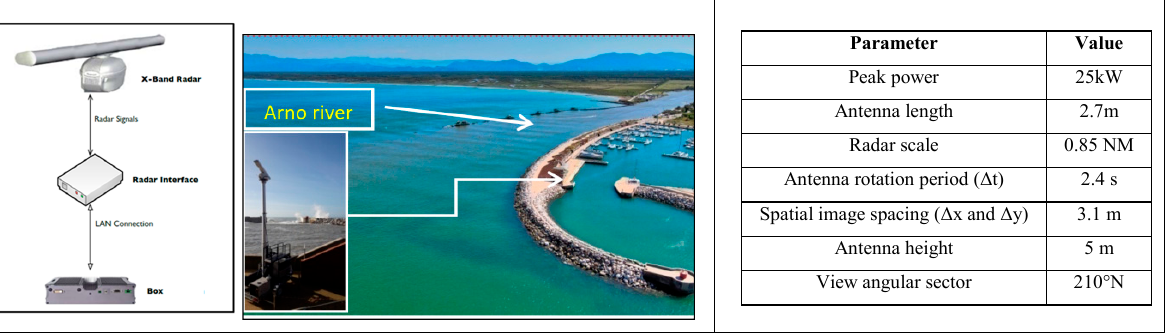
Figure 2. Wave Radar system: hardware architecture on the left. In the middle: photo of the installation site at the port of Marina di Pisa. On the right are the listed Radar system parameters. The Wave Radar system, with each radar antenna revolution, scans the sea surface with a high spatial and temporal resolution; this is achieved by the interaction (backscattering) of the electromagnetic waves (microwaves) emitted by the radar with the capillary waves (ripples) generated by the wind on the sea surface. The backscatter intensity received from the sea surface is transferred via an isolated buffer to the AD converter in a PC. The intensity of the reflected radar signal decreases with the fourth power of the distance. Currently, the analysis is restricted to an area of a few kilometres from the radar; in fact, at greater distances, due to the attenuation of the signal received, the backscattered energy input from the sea becomes more like noise than a signal. In the Wave Radar system, the data are stored, and wave analysis is conducted. One Wave Radar measurement is based on the analysis of several radar images (default is 32 imag- es). The resulting wave information, including individual wave spectra and a time series of the main statistical wave parameters, are stored and displayed on the Wave Radar graphical user interface (GUI) [62,63].